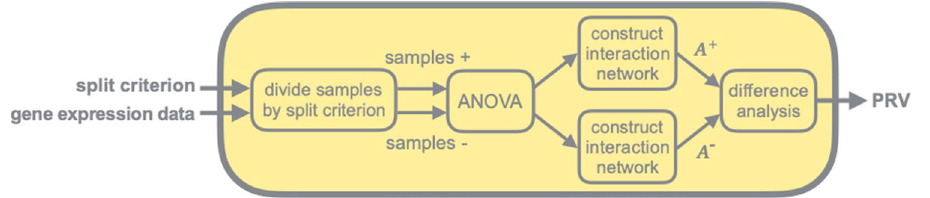
Figure 5. Systems biology feature selector. The required inputs for the systems biology feature selector are a prognostic-relevant split criterion and unlabeled samples with gene expression values. The output is the PRV for each gene feature, which was used to rank and select the